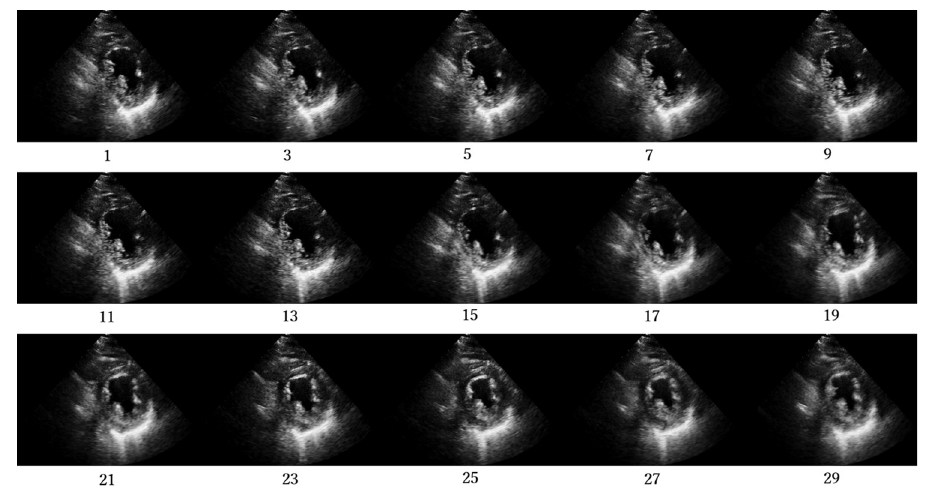
Fig 21. True-negative cases on short-axis view papillary muscle level images.